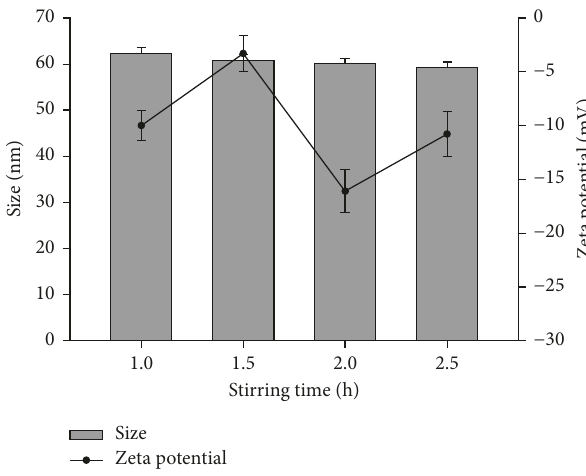
Figure 1: Effect of TPGS concentration on the size and zeta po- tential of Cur-TPGS-PMs.